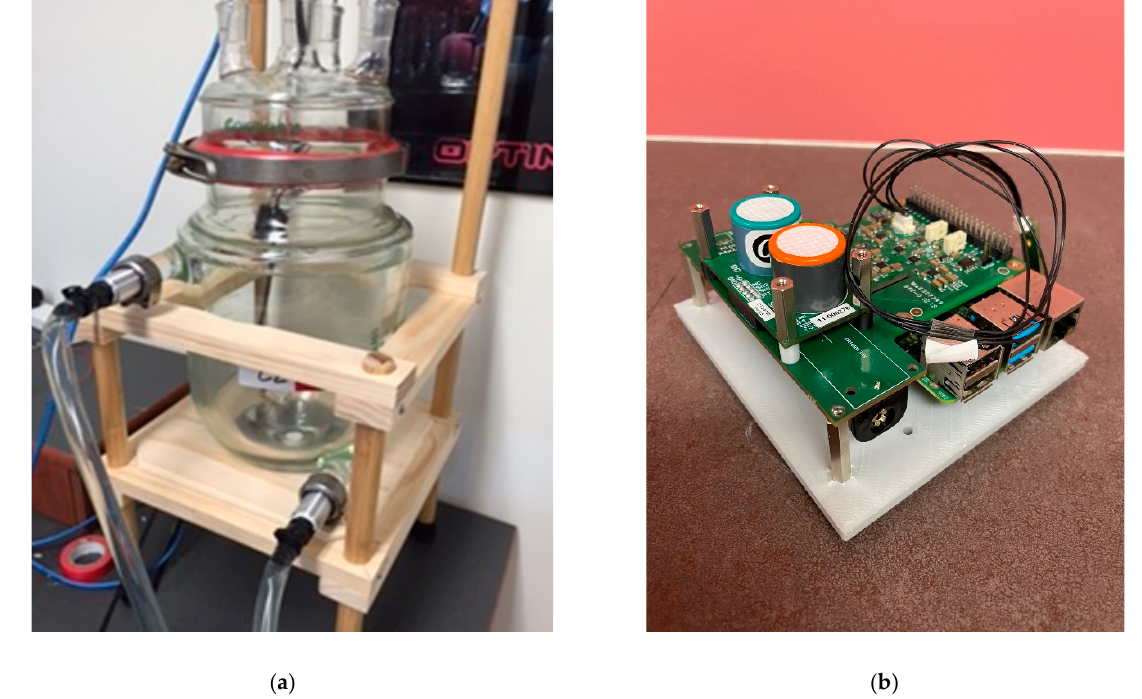
Figure 1. ( a ) Environmental chamber constructed from a Chemglass CG-1929-29 5-L double-walled reaction vessel fitted with a CG-1941 4-neck reaction vessel lid. ( b ) Low-cost electrochemical sensor showing Alphasense sensors attached to South Coast Science DFE.